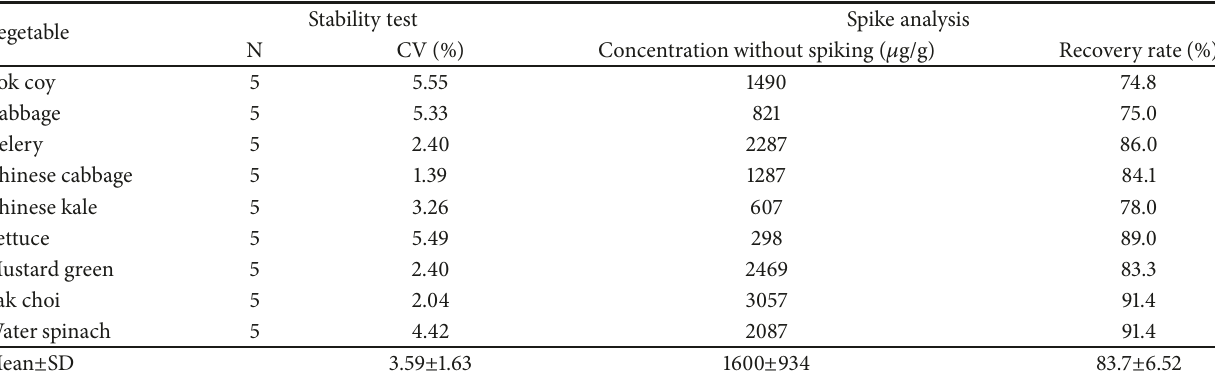
Table 3: Results from stability tests and spike analyses.